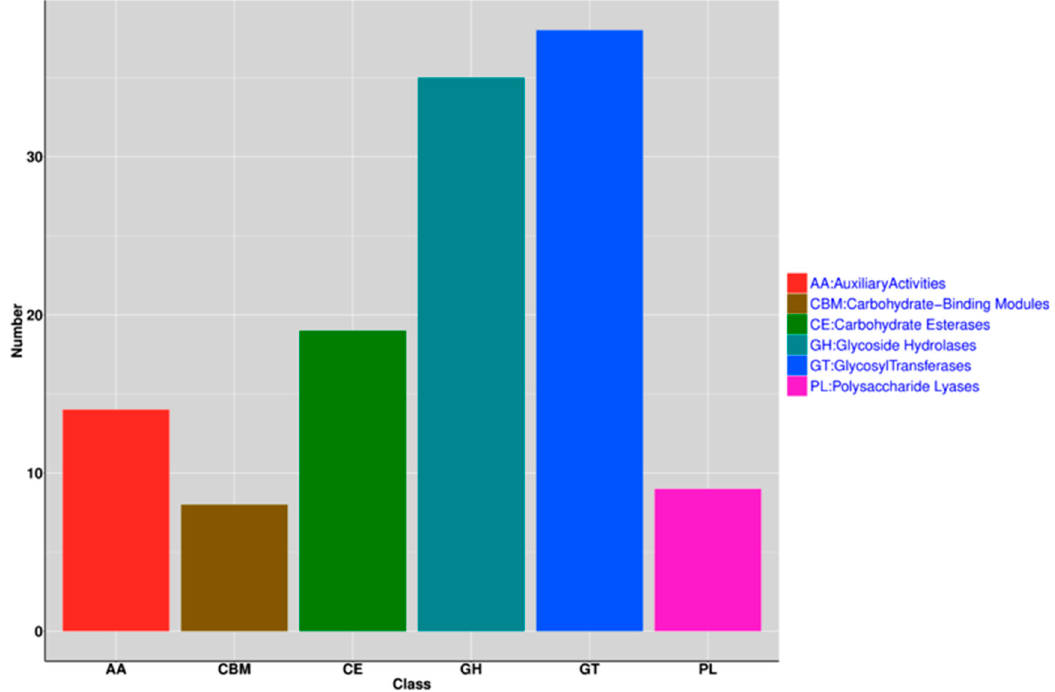
Figure 6. Analysis of CAZy in the L. sakei genome.